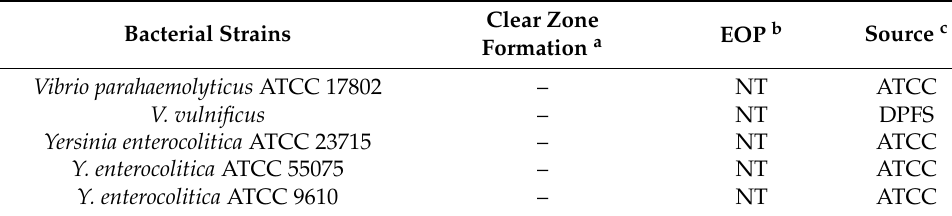
Table 1. Cont. Bacterial Strains